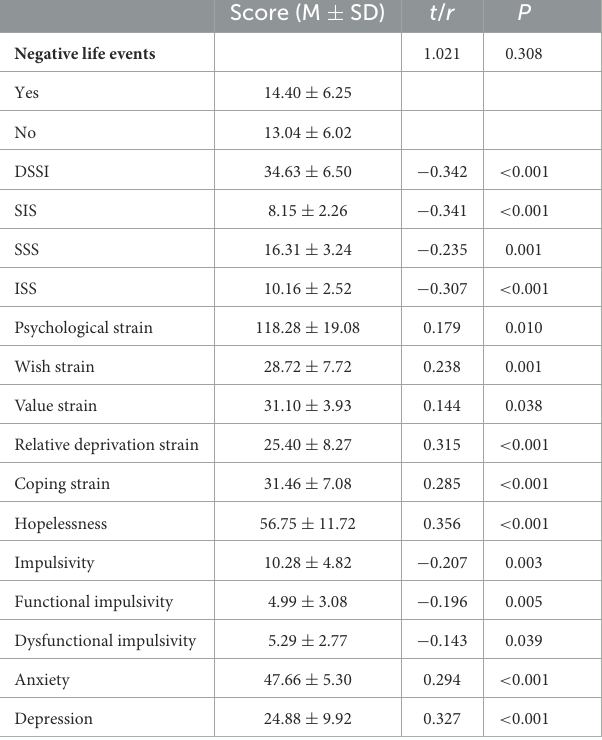
TABLE 4 Correlation analysis for the association between the social support score in patients with intentional acute pesticide poisoning and suicide intentionality ( n = 207).